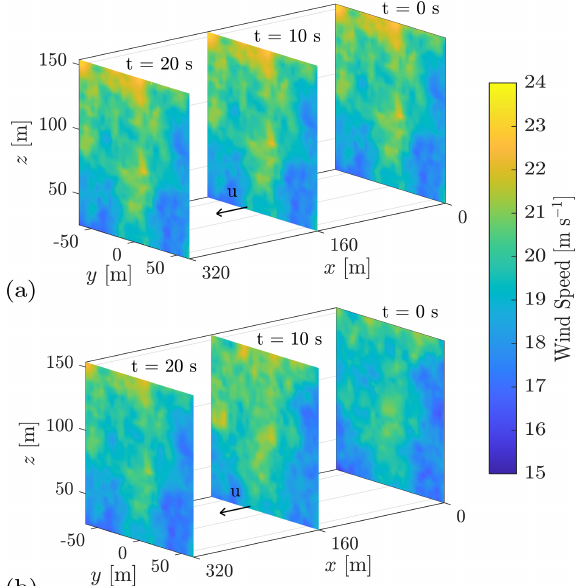
Figure 1. (a) A frozen turbulent wind field generated with the Mann turbulence generator. (b) An unfrozen turbulent wind field gener- ated with the open-access tool evoTurb by combining multiple wind fields from the Mann turbulence generator. The turbulence prop- erties are as follows: mean wind speed = 16ms − 1 , turbulence in- tensity = 0.16, and shear exponent = 0.2. Only the U component is